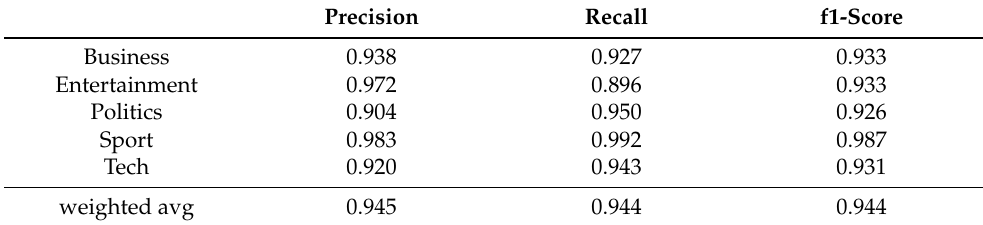
Table 5. Classification statistics for predicting preassigned classes by detected dominant topics ( γ = 0.8). Precision is the fraction of true positives among all positive predictions, recall is the fraction of true positives compared to all actual class members, and the f1-score is their harmonic mean. Values are given for each class separately and as an average weighted according to the sizes of the